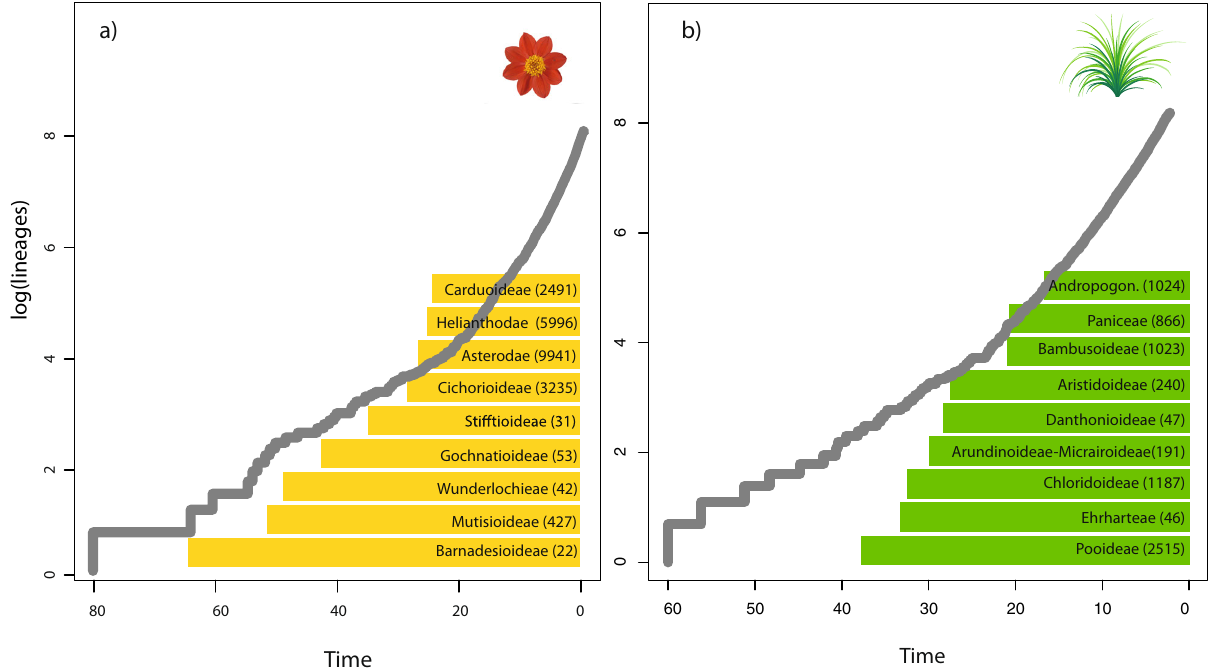
Fig. 2 Lineage-Through Time (LTT) plots of daisies and grasses. Solid gray lines represent LTT curves derived from time-calibrated phylogenetic trees of a Asteraceae and b Poaceae (calibration scenario #1). Colored boxes depict the name and number of non-sampled (missing) species per clade that we integrated in our empirical taxon sampling. The shape of LTT curves have demonstrated to be a convenient summary metric for diversi fi cation diagnostics, particularly when diversi fi cation deviates from the expectation of constant rates 81,82 . However, the distribution of missing species might not be uniform — as it is the case of these angiosperm families — and can severely impact on diversi fi cation-rate estimates. Our work shows that the most important increase in diversi fi cation rate for both Asteraceae and Poaceae is completely unnoticeable using the LTT analysis, even when calibrated phylogenetic trees include a large number of